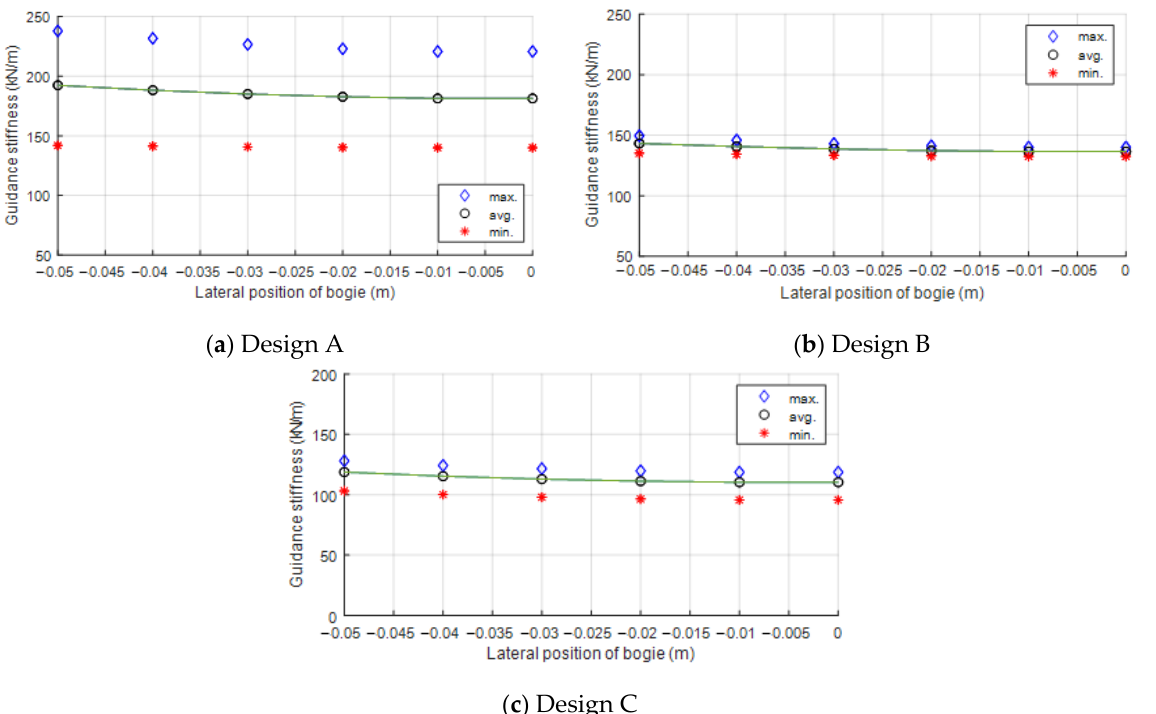
Figure 12. Relationship between guidance stiffness and lateral position (average).